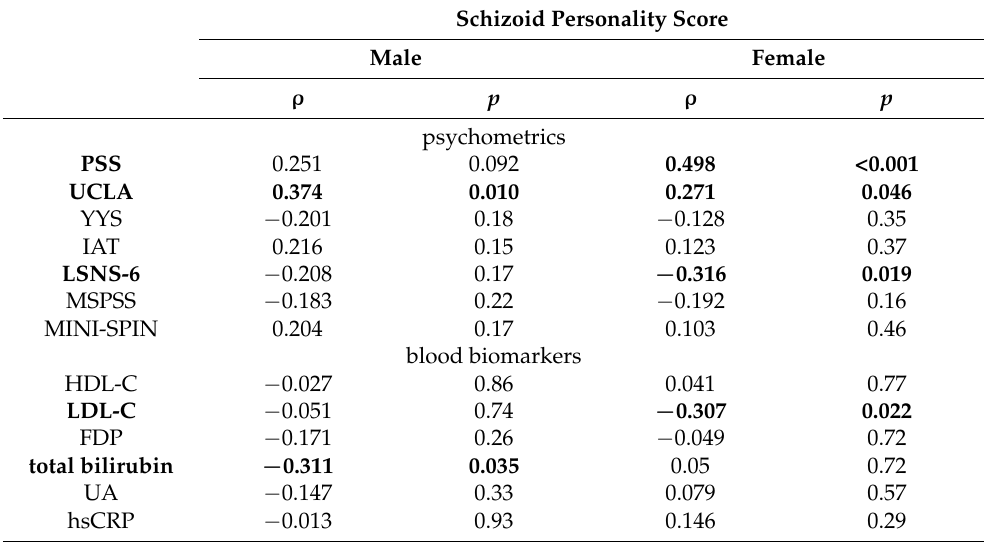
Table 3. The relationships between schizoid personality scores, psychometrics, and blood biomarker levels.